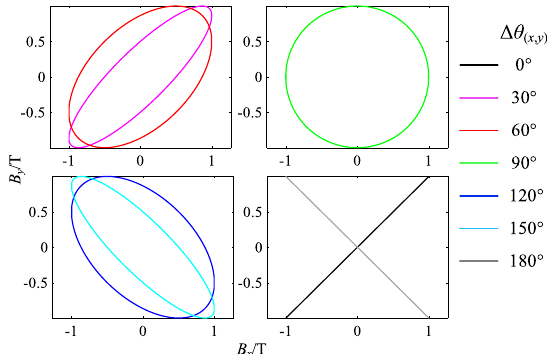
Fig. 4 Lissajous figure with different initial phase angle